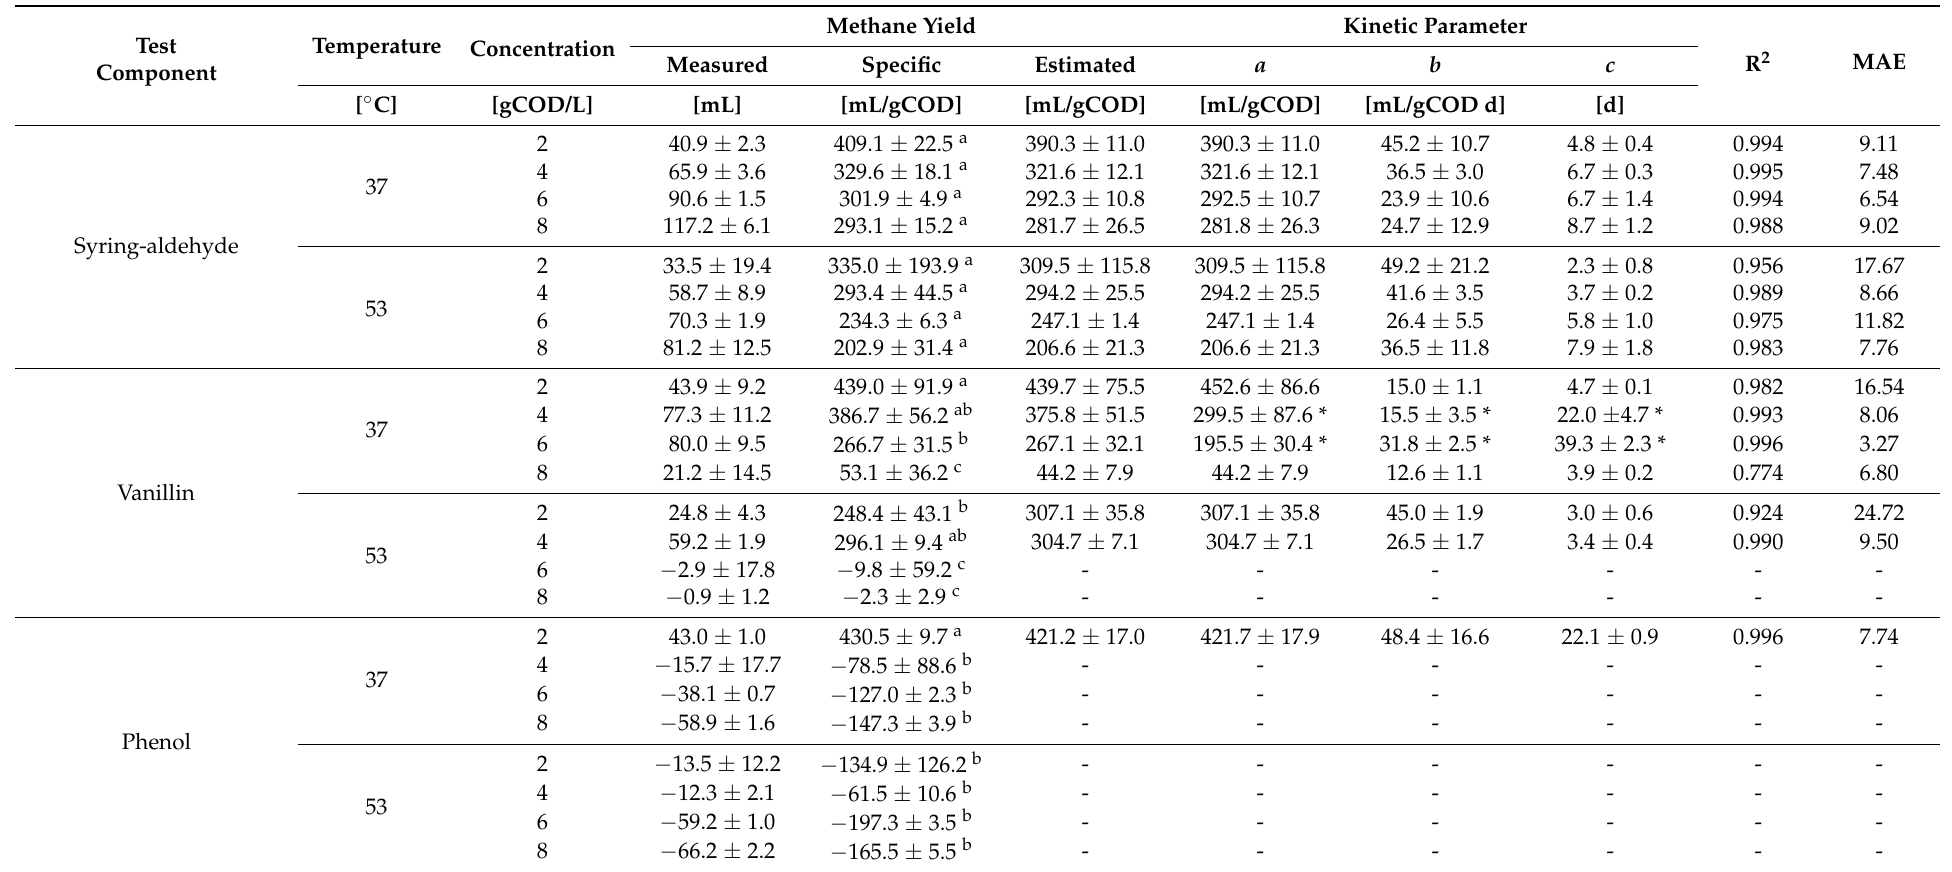
Table 7. Mean methane yields for given concentrations of phenolic compounds under mesophilic and thermophilic conditions with kinetic parameters ( a :